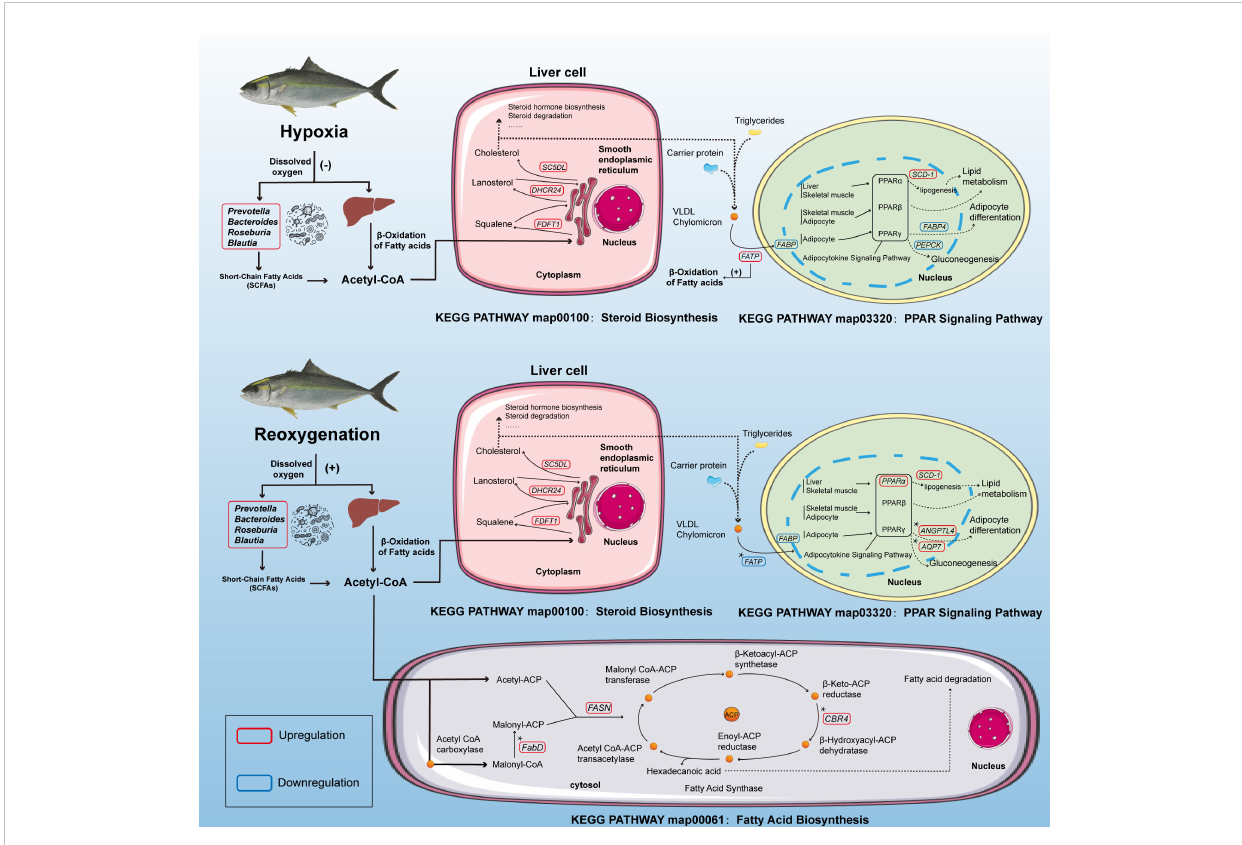
FIGURE 10 Changes in lipid metabolism in yellowtail king fi sh under normoxia vs hypoxia and normoxia vs reoxygenation. * Indicates genes signi fi cantly regulated in hypoxia vs